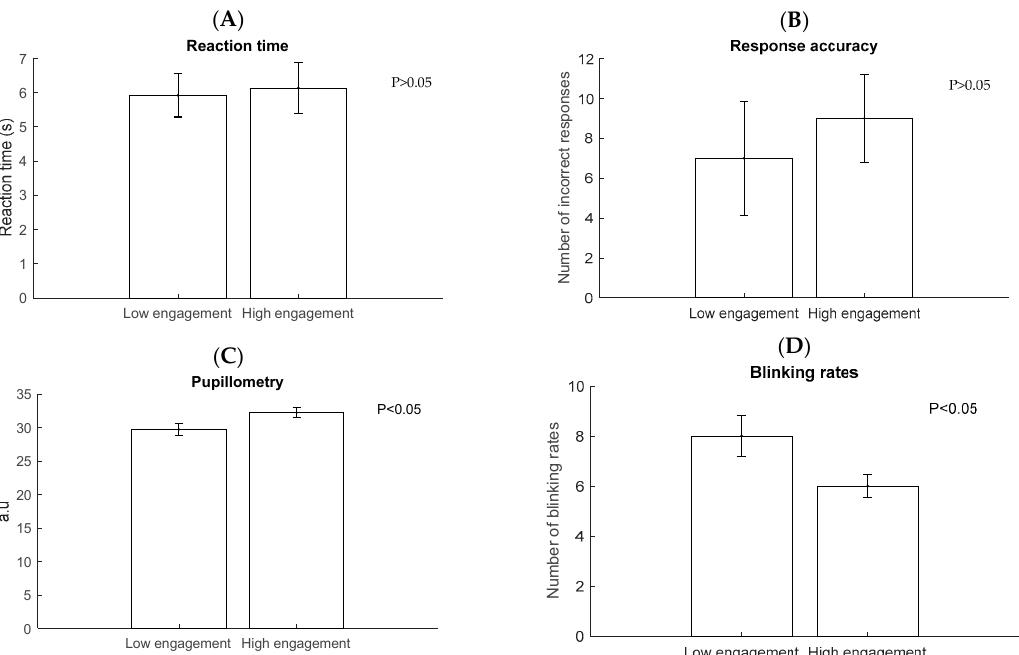
Figure 7. Mean ± SE of reaction time ( A ), incorrect response ( B ), pupilometry ( C ) and Blinking rates ( D ) in high engagement and low engagement ( n = 11).